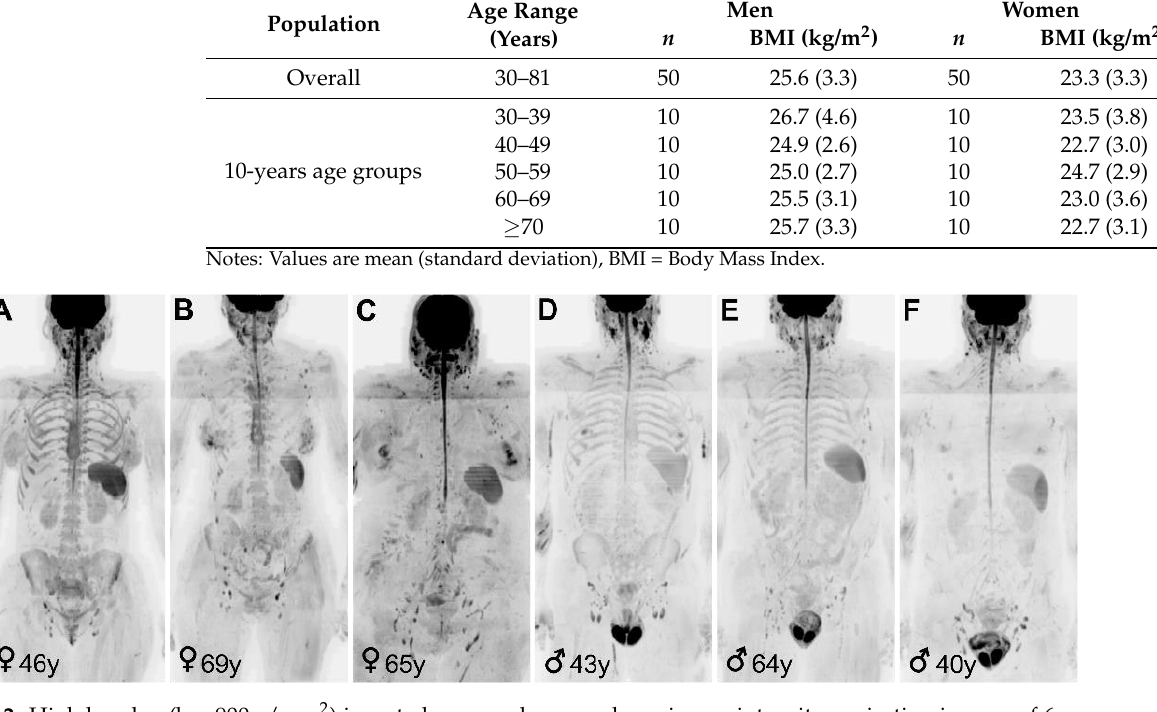
Figure 2. High b-value (b = 900 s/mm 2 ) inverted gray-scale coronal maximum-intensity-projection images of 6 asympto- matic individuals. ( A ) In our cohort, the bone marrow signal intensity of women ( ♀ ) aged between 30 and 50 was higher compared to the bone marrow signal of older women ( B ) and adult men ( ♂ ) of all age groups ( D , E ). This difference may be attributable to the higher cellularity, water content and possibly higher perfusion of pre-menopausal women bone marrow. Images ( C , F ) show two examples of individuals for which the semi-automatic segmentation method used in this study was not applicable, due to hypointense bone marrow signal intensity on high b-value inverted gray-scale coronal maximum-intensity-projection images.